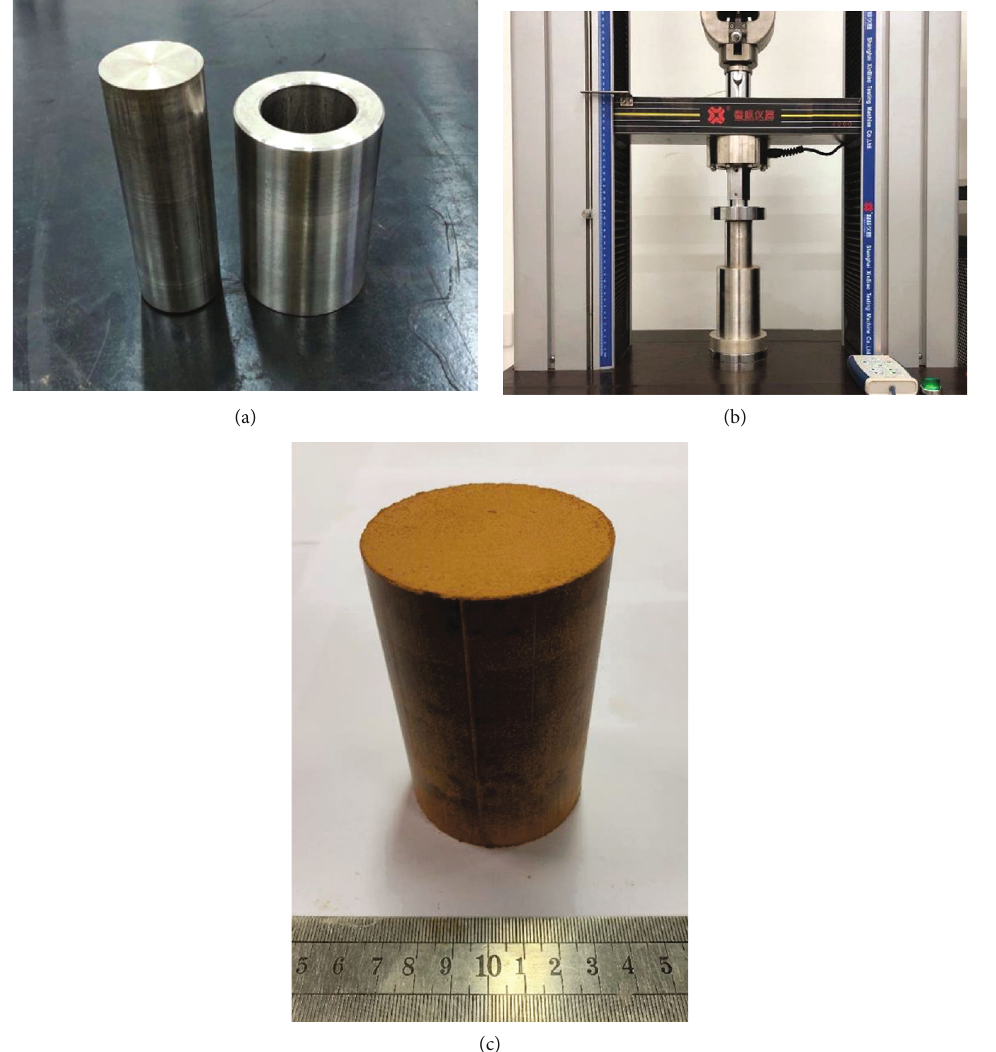
Figure 2: The compaction process (a) Mold. (b) Universal testing machine. (c) Remolded specimen. Table 2: Speci fi cations of the viscoplastic tests.